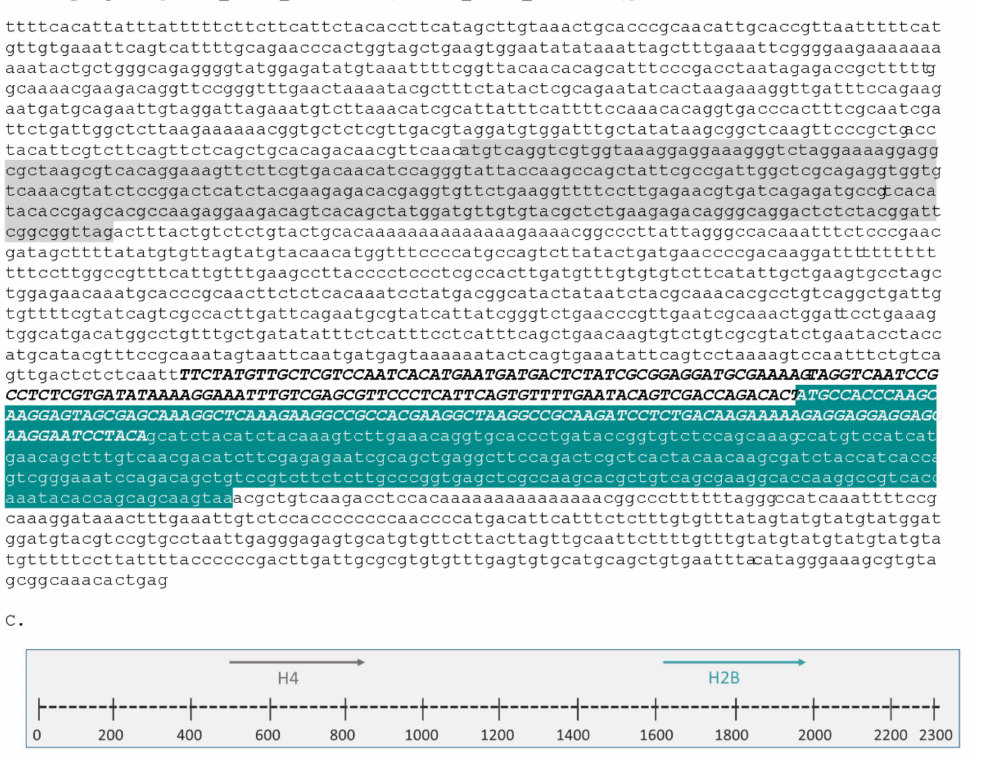
Figure 9. The H4 gene precedes the H2B gene in the Lucina pectinata genome . ( A ) BLASTN analysis between sequences containing the H4 and H2B genes obtained from the draft genome show an overlap of 255 bp, suggesting these two sequences can form a larger contig. ( B ) The contig containing the H4 and H2B genes resulted in a 2337 bp long sequence. The H4 coding region is highlighted in gray and the H2B coding sequence is highlighted in teal. The common overlapping region of 255 bp is indicated in bold/italic uppercase letters. ( C ) Schematic representation of the H4 (gray colored arrow) and H2B (teal colored arrow) genes localization, arrows indicate the direction of transcription (5 (cid:48) → 3 (cid:48) ). The histone RNA sequences retrieved from the transcriptome assembly were partially confirmed by RT-PCR. All histone mRNAs had the typical palindromic sequence (underlined in Figures 4–8) that is capable of forming a stem-loop structure, typical of replication-dependent (RD) histone genes, close to the stop codon. The conserved central domain found in histone H1 proteins was also found in the two H1 variants we identified in our study. At the nucleotide level, Purine-rich elements (in